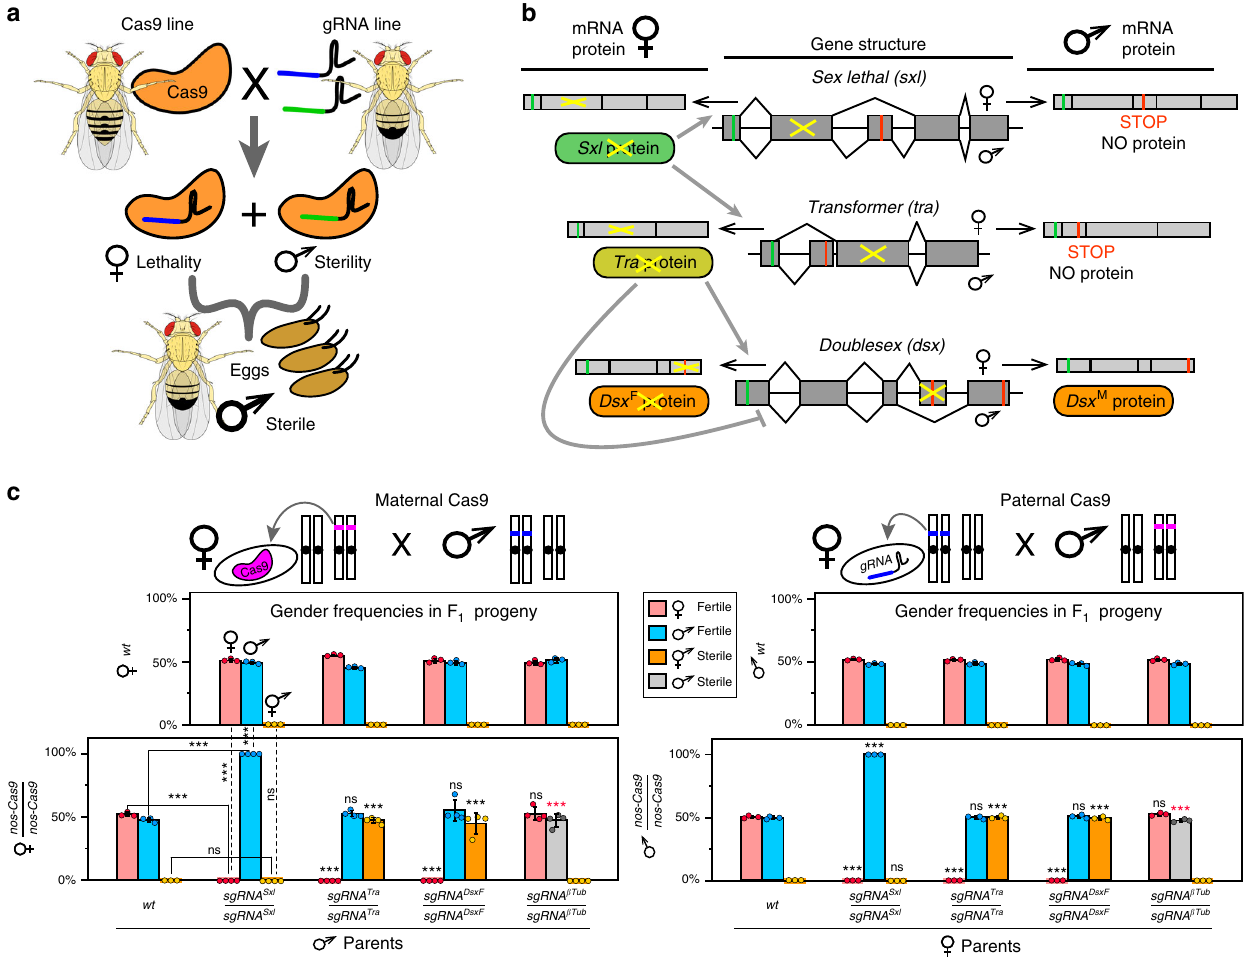
Fig. 1 Precision guided sterile insect technique (pgSIT), an assessment of gene targets with single guide RNAs (sgRNAs). a A schematic of pgSIT utilizing two components of the binary CRISPR/Cas9 system, Cas9 and gRNAs, maintained as separated homozygous lines, their cross results in simultaneous knockouts of a gene required for female viability and a gene required for male fertility resulting in survival of only F 1 sterile males. b A schematic of sex- speci fi c alternative splicing in sxl , tra, and dsx regulated by female expression of Sxl and Tra proteins (gray lines) (modi fi ed from ref. 68 ). Disruption of female-speci fi c exons of key sex-determination genes, sxl , tra , and dsx , disrupts female development. PgSIT exon targets indicated by yellow crosses. c Bar graphs of average gender frequencies in F 1 progeny. Two top panels depict gender frequencies from bidirectional control crosses of homozygous sgRNA lines to wild type ( wt ), indicating that both fertile females and males ( ♀ and ♂ ) are present at similar ratios, but no sterile intersexes ( ⚥ ) were identi fi ed. Bottom two panels show gender frequencies from crosses of homozygous nanos-Cas9 ( nos-Cas9 ) to wt (control) and four homozygous sgRNA lines (experiment). Independent of maternal or paternal Cas9 inheritance, 100% of trans-heterozygous sgRNA Sxl females were lethal, 100% of trans- heterozygous sgRNA Tra and sgRNA DsxF females were masculinized into sterile intersexes ( ⚥ ), and 100% of trans-heterozygous sgRNA β Tu males were sterile. Gender frequencies and fertility in trans-heterozygotes were compared to those in the corresponding progeny of control crosses with nos-Cas9 (solid lines) or sgRNAs (dashed lines) and wt fl ies. Bars represent means± SD for three/four independent groups of parental fl ies. P> 0.001*** by a t test assuming unequal variance (black *) or, for male sterilization by Pearson ’ s chi-squared test for contingency tables (red